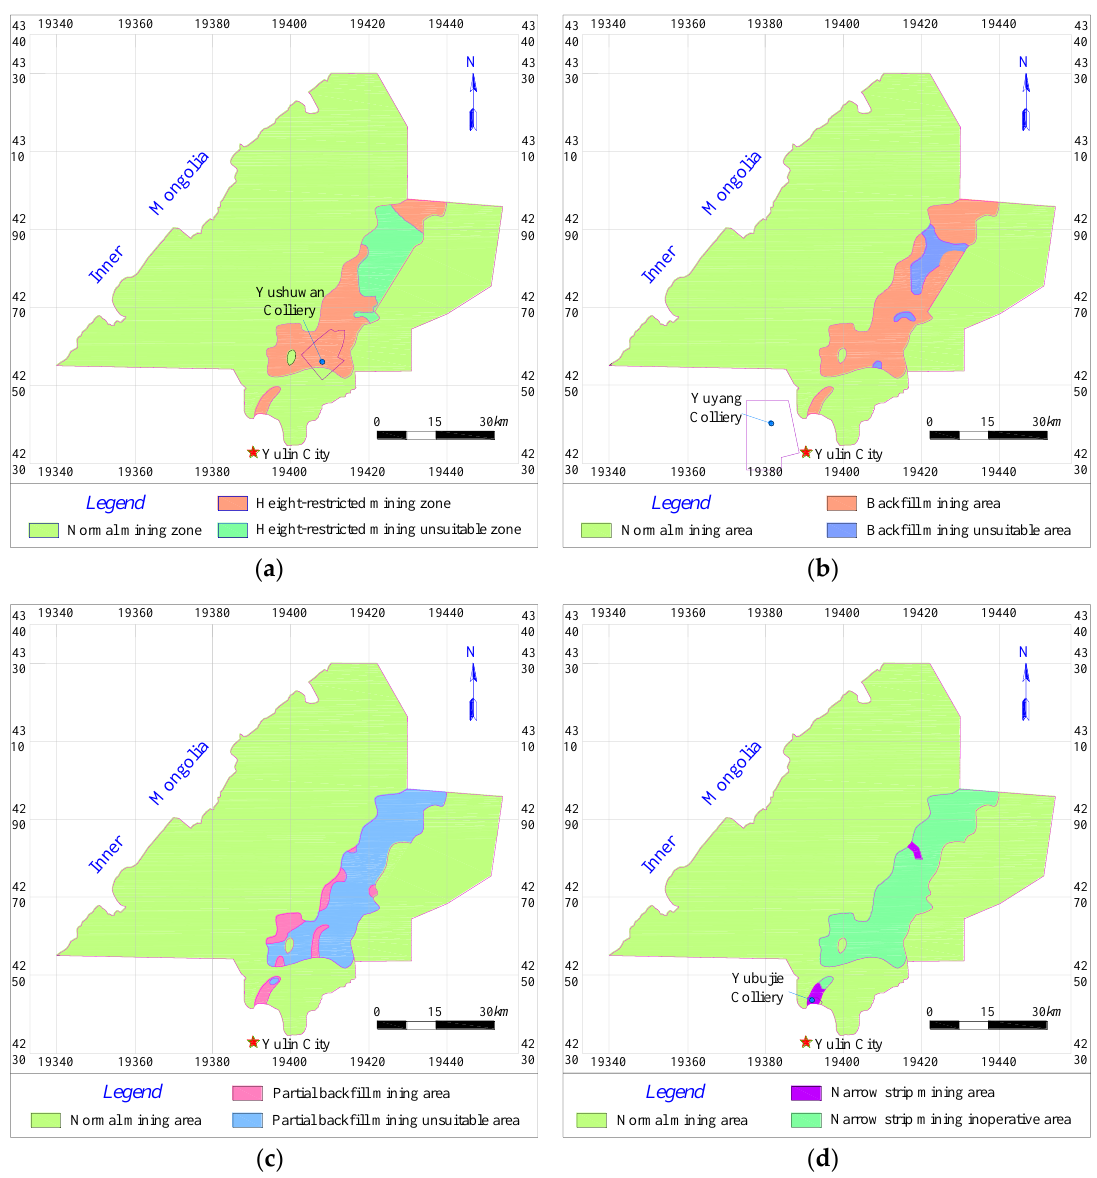
Figure 18. Applicability partition of water conservation coal mining method (Xi'an geodetic coordinate system 1980; in km): ( a ) Height-restricted mining application area; ( b ) Backfill mining application area; ( c ) Partial backfill mining application area; ( d ) Narrow strip mining application area.